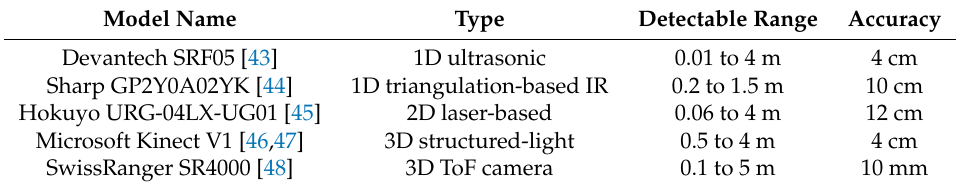
Table 1. Main features of common range sensors in mobile robotics. Here, the accuracy reported is the worst-case error w.r.t the true distance, and the type of sensor includes the number of dimensions and the measurement